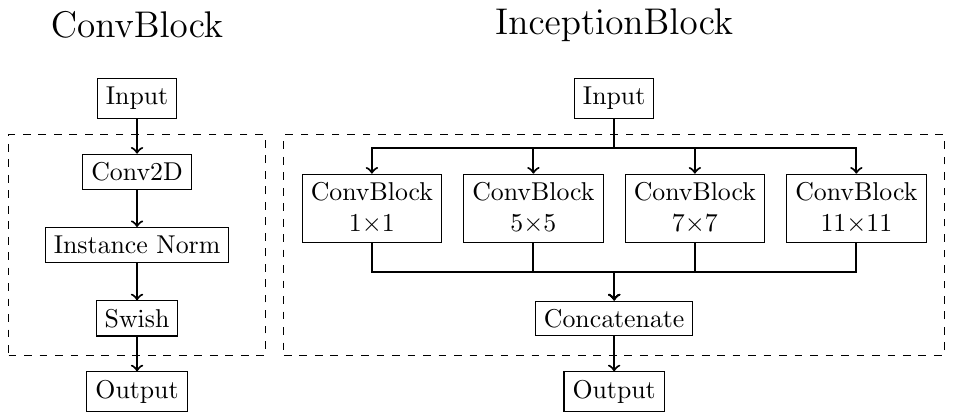
Figure 1. Basic building block architectures. The ConvBlock ( left ) is composed of a 2D convolutional step with kernel variable kernel size, followed by instance normalization and a Swish activation function. The InceptionBlock ( right ) is composed of the parallel combination of more ConvBblock with kernel dimension of 1 1, 5 5, 7 7, and 11 11. The output of each ConvBlock is then × × × × concatenated in a single output tensor.